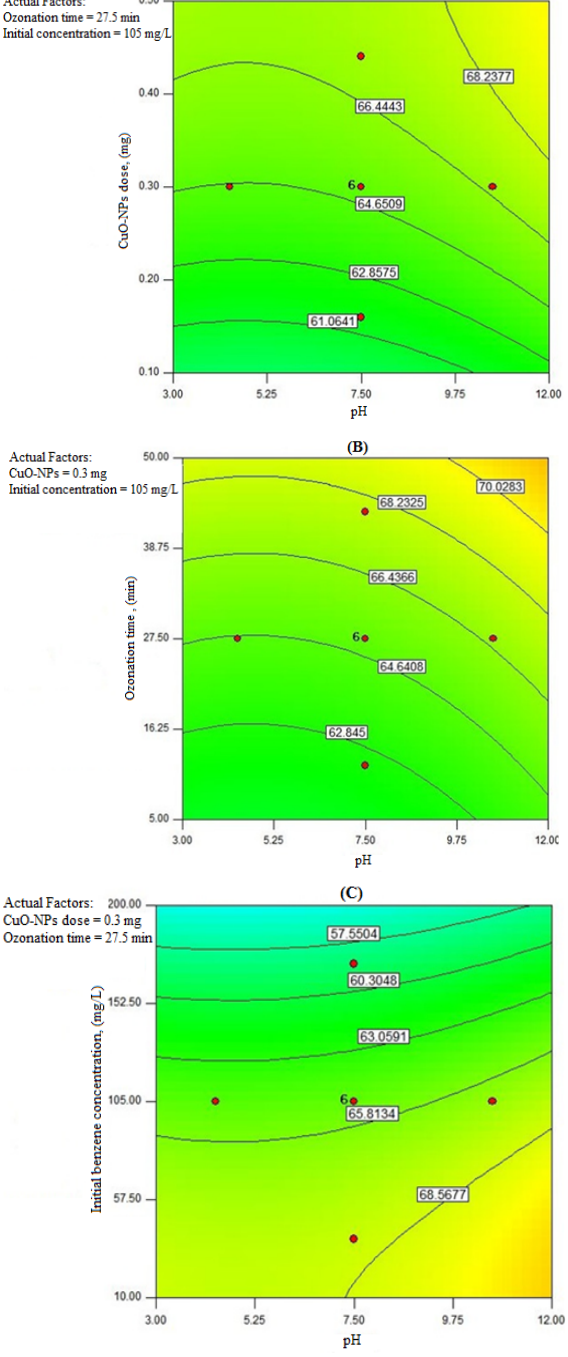
Fig. 3: (A) Interaction effects of pH and CuO-NPs dose,(B) pH and ozonation time, and (C) pH and initial concentration of benzene on benzene removal by